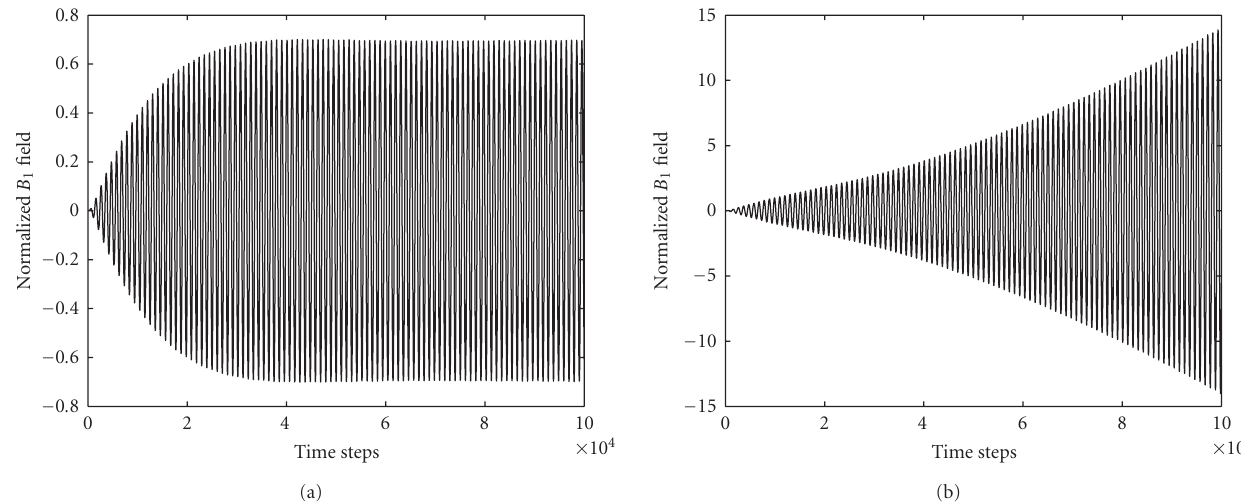
Figure 4: Calculated B 1 -field at the center of the coil. (a) PML with N p = 10 and N s = 10. The B 1 -field is stable after 40 000 time steps; (b) PML with N p = 5 and N s = 5. The B 1 -field increases monotonically even after 100 000 time steps.